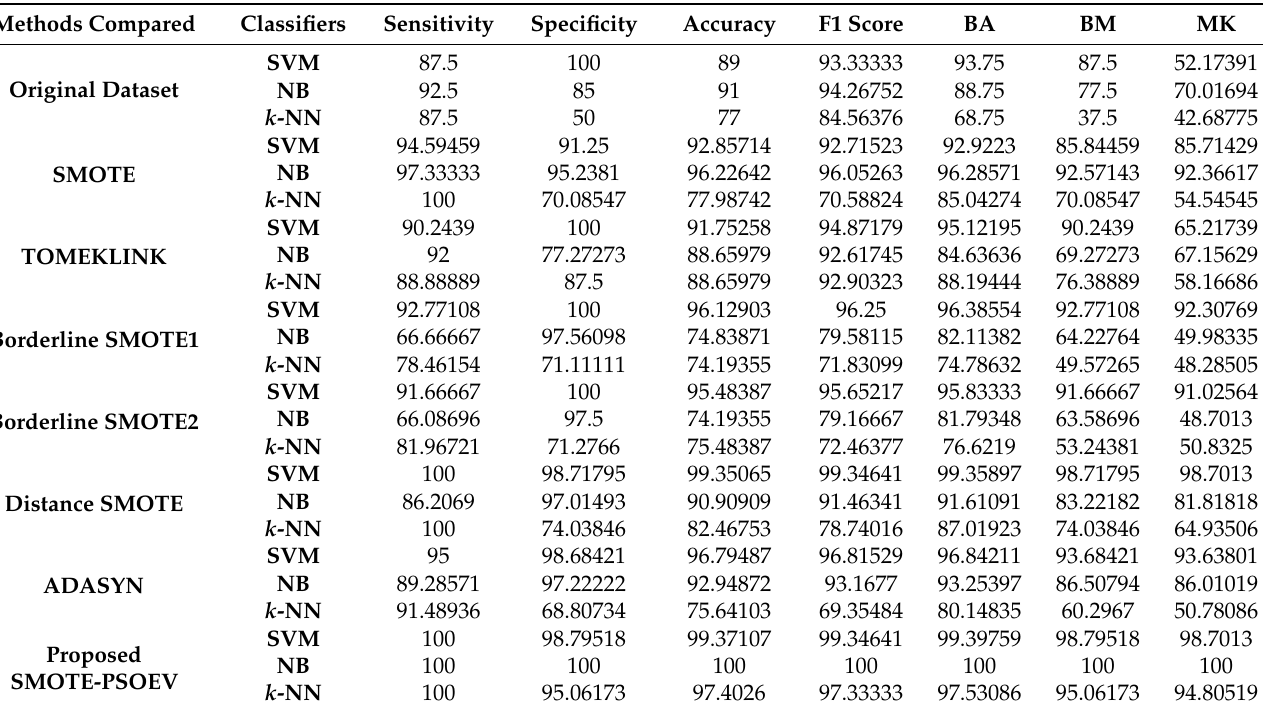
Table 5. Performance recognition (in %) of Ecoli1